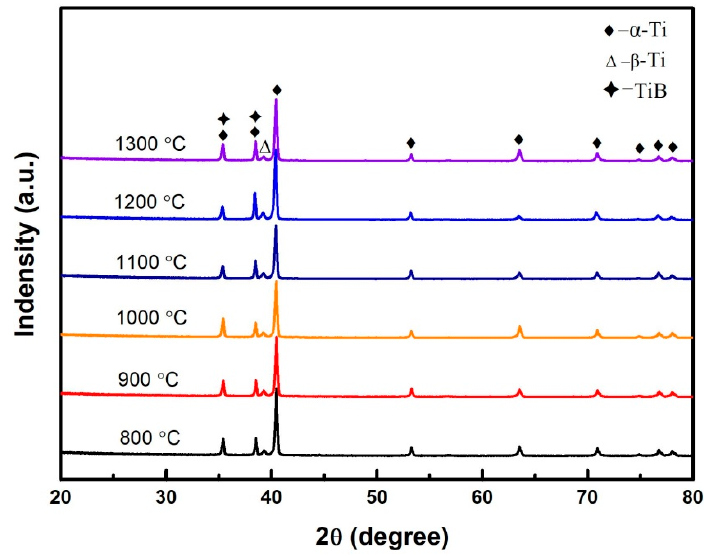
Figure 2. The X-ray diffraction patterns of composites sintered at 800–1300 °C for 60 min.